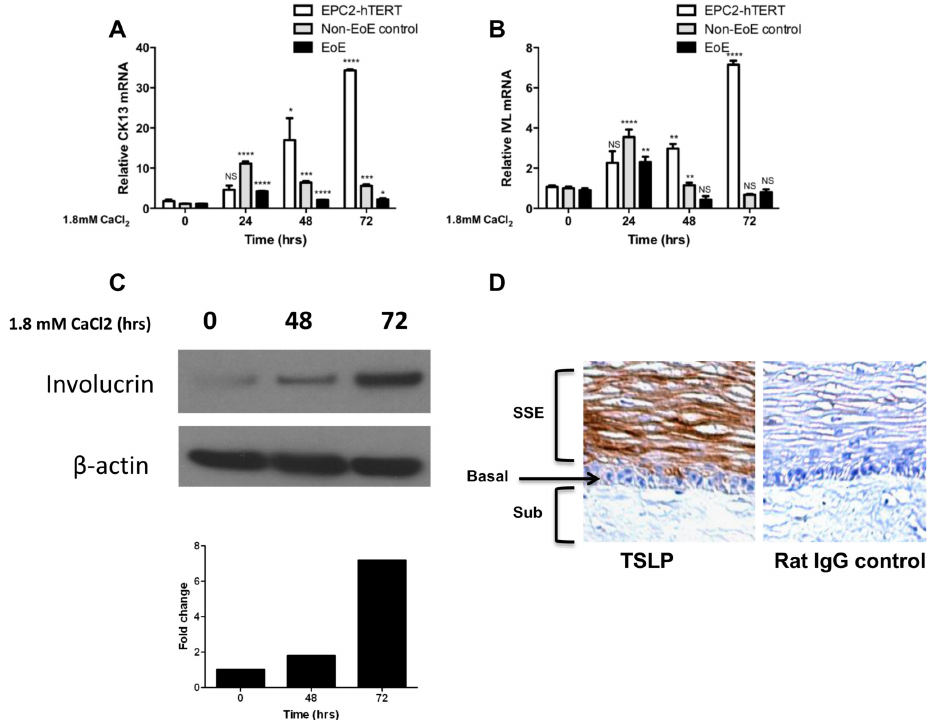
Fig 2. Calcium induces terminal differentiation of esophageal epithelial cells in-vitro A) Cytokeratin 13 (CK13) and, B) involucrin (IVL), mRNA expression in response to high calcium (1.8mM CaCl 2 ) media at 0, 24,